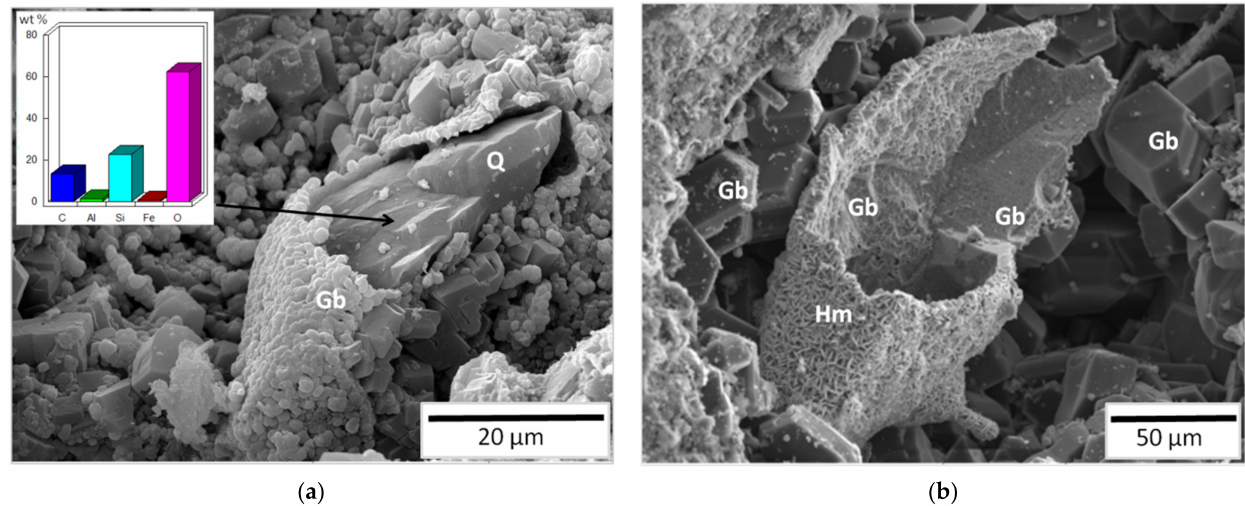
Figure 10. SEM images: relic of quartz grain surrounded by a brush of biogenic gibbsite ( a ), part of the biofilm around dissolved quartz grains: inside, brush of gibbsite crystals; outside: brush of hematite biomorphs ( b ). Gb: gibbsite, Hm: hematite, Q: